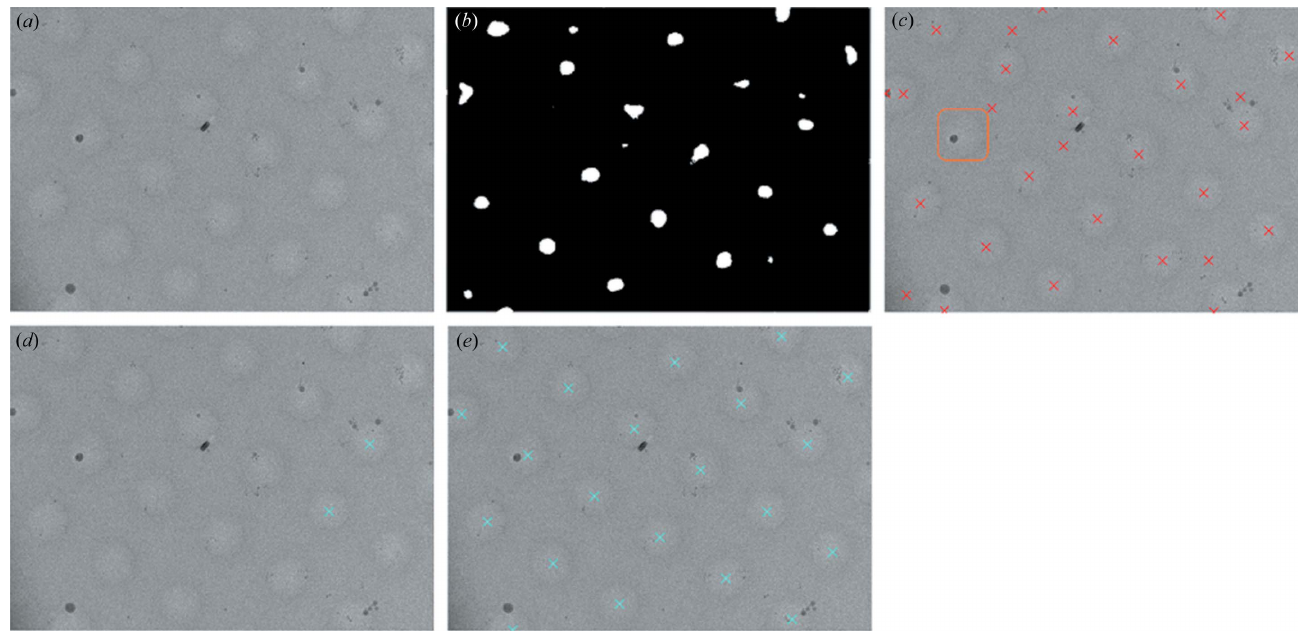
Figure 7 Example hole-center detection on a difficult image. On this low-contrast image, lattice fitting extends to missed holes while removing erroneous detections. ( a ) Input image. ( b ) U-Net output. ( c ) Centroids from high-probability regions in U-Net output (red). Many locations outside holes are detected incorrectly, and one hole (orange) is missed. ( d ) Running the optimal-lattice-finding algorithm results in finding lattice anchor points (cyan). ( e ) The lattice generated by these anchor points (cyan) results in coverage of all holes and cleans the incorrect